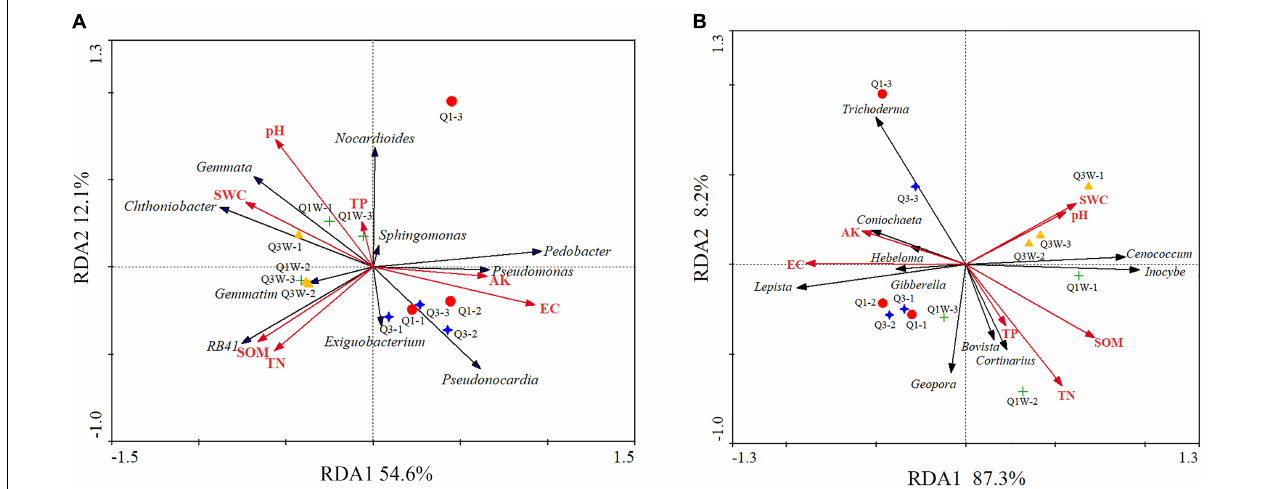
FIGURE 4 | Redundancy analysis (RDA) ordination biplot showing the relationships between soil properties and bacterial and fungal communities different samples of fairy ring. (A) bacteria; (B) fungi. AK, available K; TN, total N; TP, total P; SOM, soil organic matter; WC, water content; EC, electronical conductivity.